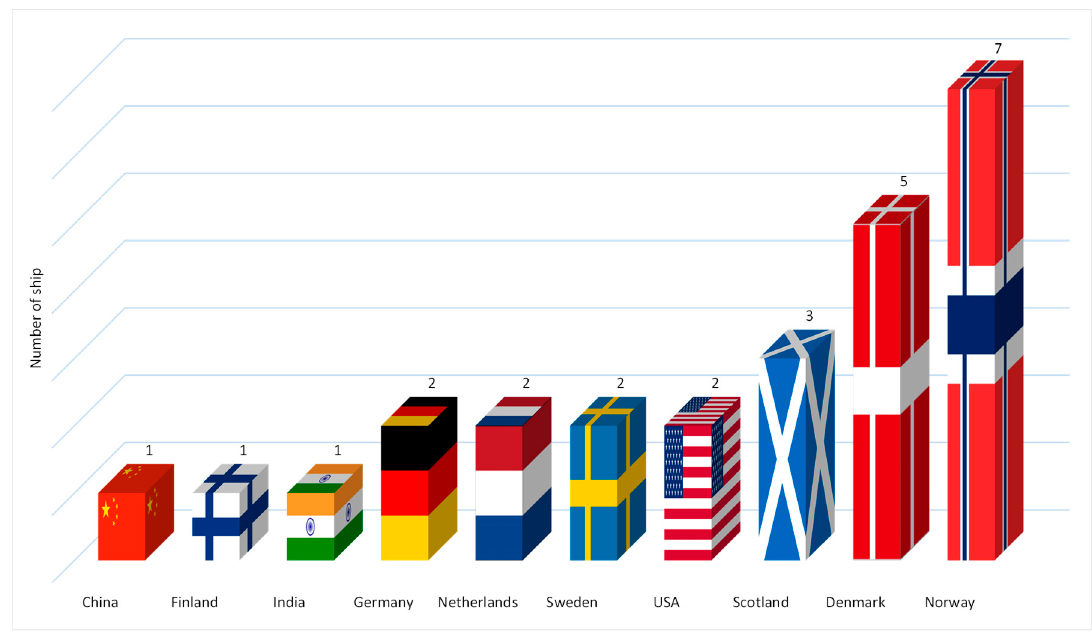
Figure 4. Countrywide electrification of ships. Energies 2020 , 13 , x FOR PEER REVIEW